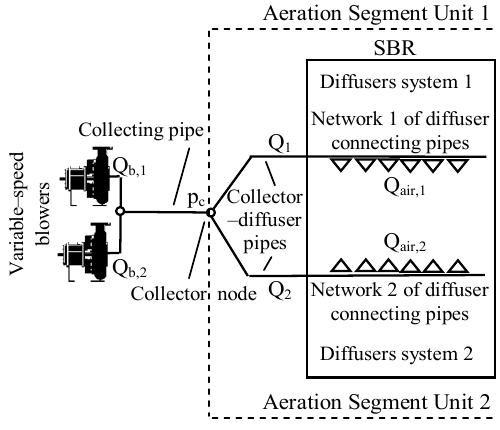
Figure 2. Structure of the Swarzewo aeration system.